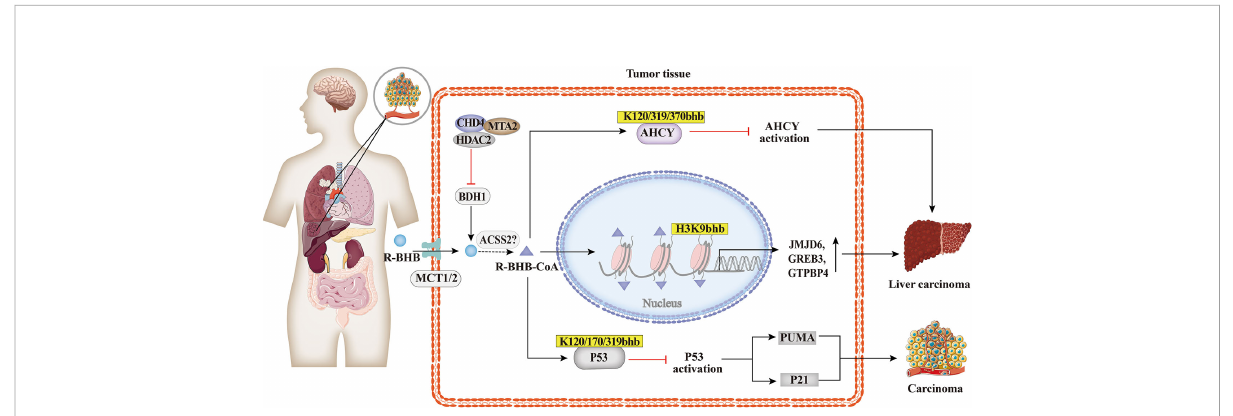
FIGURE 6 Histone Kbhb in tumors. Studies suggested that BHB or BHB induced PTMs may play an important role in the pathogenesis and treatment of tumors. MTA2-triggered R-loop trans-regulation of BDH1-mediated H3K9bhb and enhanced proliferation of hepatocellular carcinoma stem cells. BHB inhibited cyclase S-adenosyl-L-homocysteine hydrolase (AHCY) activity and promoted hepatocellular carcinoma proliferation via AHCY Kbhb modi fi cation of K120, K319 and K370; And then BHB inhibited P53 activity through Kbhb modi fi cation of K120, K170 and K319, which reduced the expression of the p53 downstream genes p21 and PUMA, and promoted carcinoma